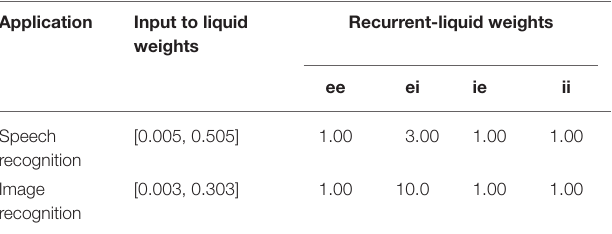
TABLE 2 | Synaptic weight initialization